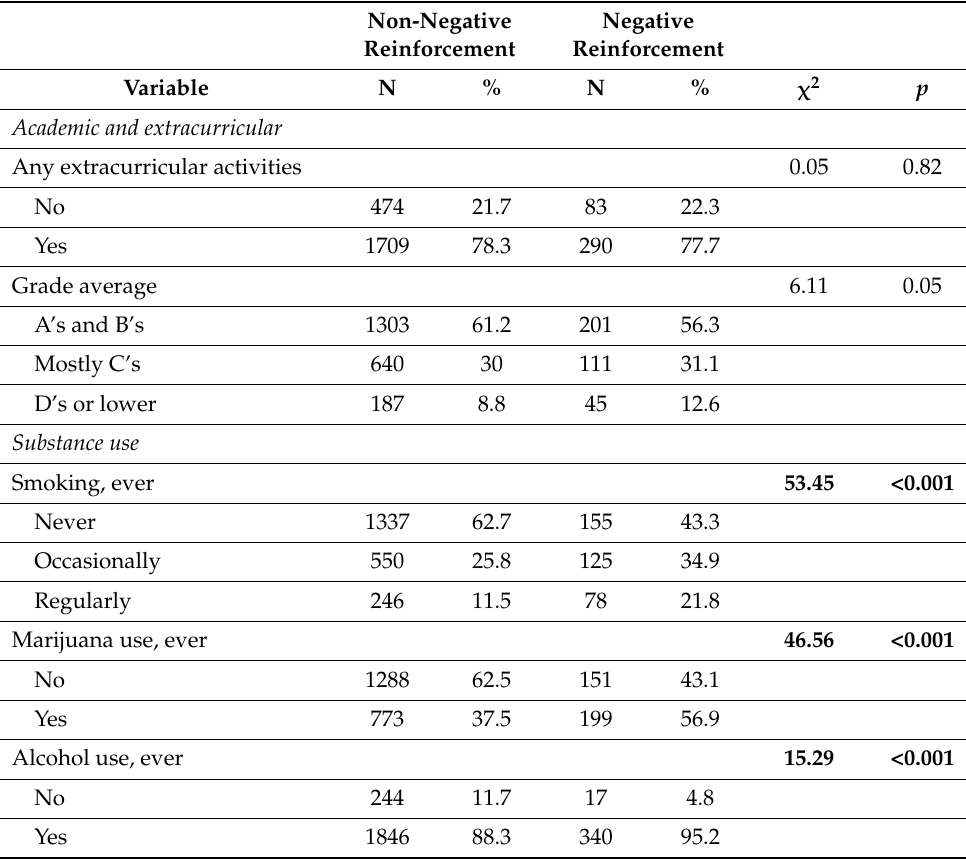
Table A1. Health correlates stratified by negative-reinforcement-shopping status